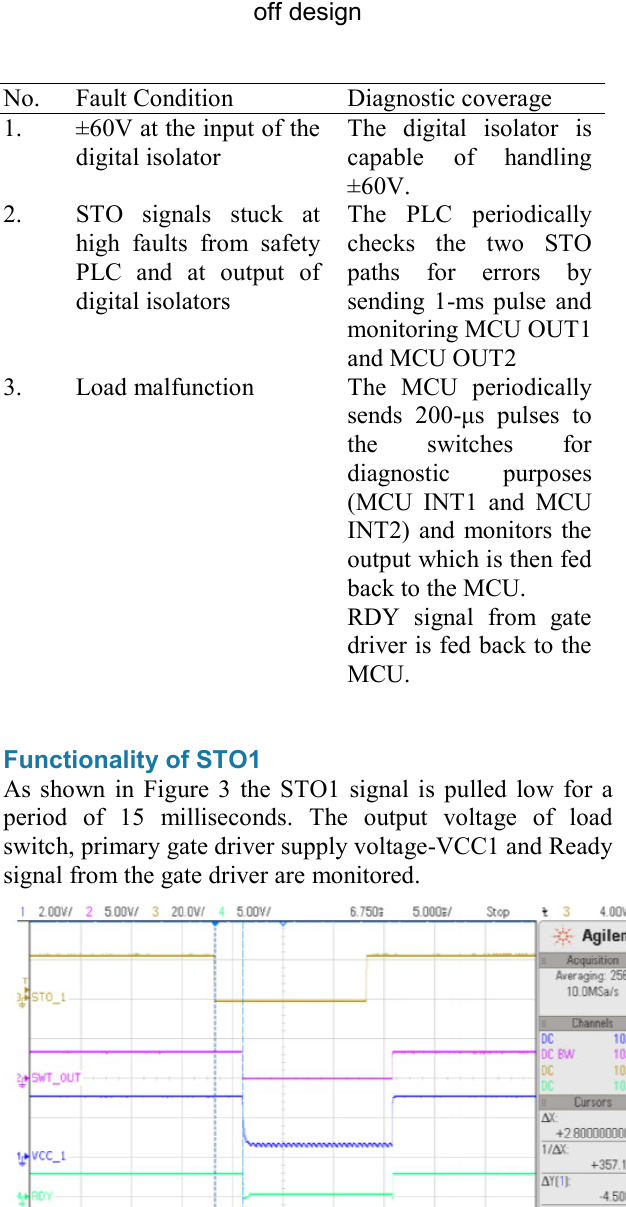
Table 1. Diagnostic coverage on proposed safe torque